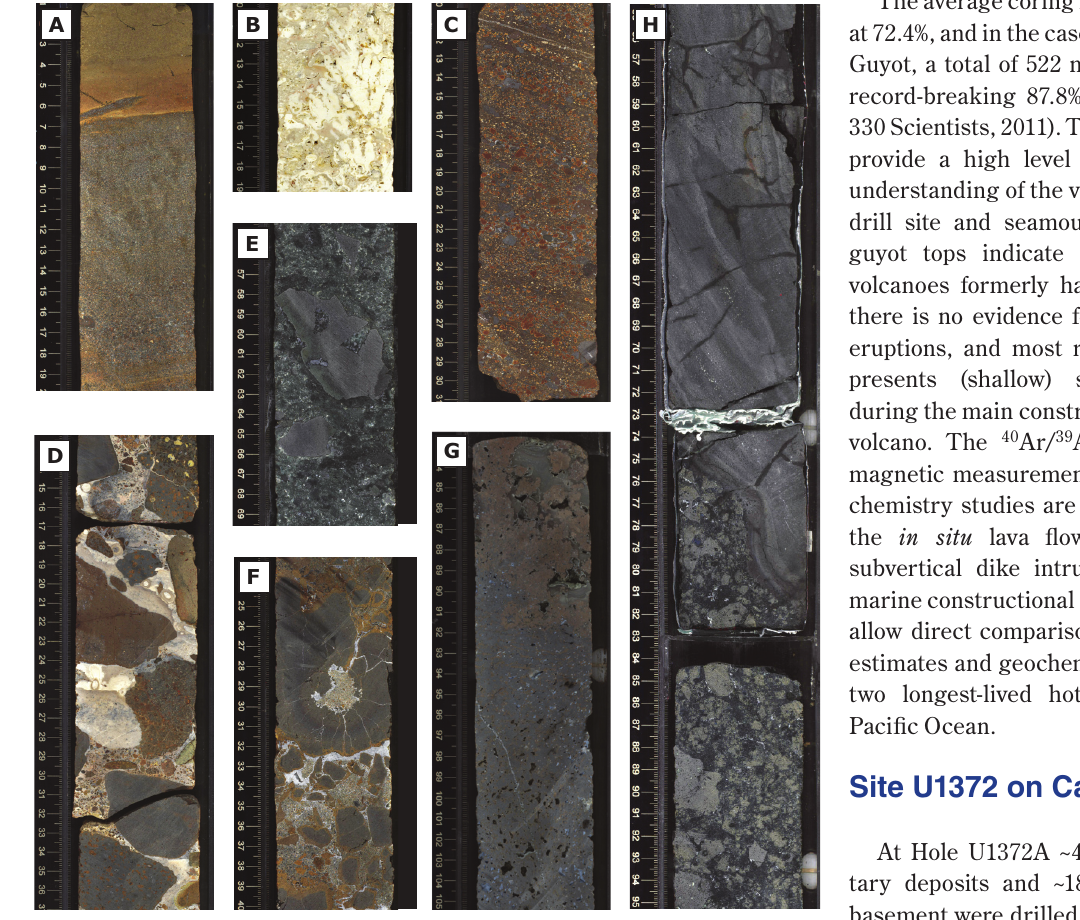
Figure 3. Lithological variation displayed in core images. [A] Monolithic bioturbated brown coarse tuff (top) and heterolithic multicolor volcanic sandstone (bottom) from Site U1376 (interval 330-U1376A-3R-4, 1–41 cm) deposited as turbidites in a hemipelagic or pelagic environment. [B] Algal boundstone with a branching growth form of algae from Site U1376 (interval 330-U1376A-3R-5, 10–29 cm) interpreted as a reef. [C] Multicolor coarse (layered) volcanic sandstone/breccia at Site U1374 (interval 330-U1374A-8R-1, 10–50 cm) interpreted to have been emplaced on a shallow-marine slope as a hyperconcentrated flow. [D] Multicolor basalt conglomerate emplaced under hemipelagic conditions at Site U1375 (interval 330-U1375A-2R-1, 1–41 cm) with inter-pebble spaces composed of foraminiferal limestone, finer-grained volcaniclastic sediment and carbonate cement. [E] Angular aphyric basalt clasts in hyaloclastite matrix at Site U1374 (interval 330-U1374A-66R-6, 55–69 cm). [F] Example of magma-sediment (peperitic) interaction observed at Site U1374 (interval 330-U1374A-17R-3, 20–40 cm). [G] Flow top at the upper (peperitic) boundary of a massive (~23-m-thick) aphyric basalt flow at Site U1373 (interval 330-U1373A-9R-2, 83–105 cm). [H] Aphyric subvertical dike intrusion (top) into hyaloclastite breccia sequence (bottom) at Site U1376 (interval 330-U1376A-15R-2A, 22–95 cm). Figure after Koppers et al.